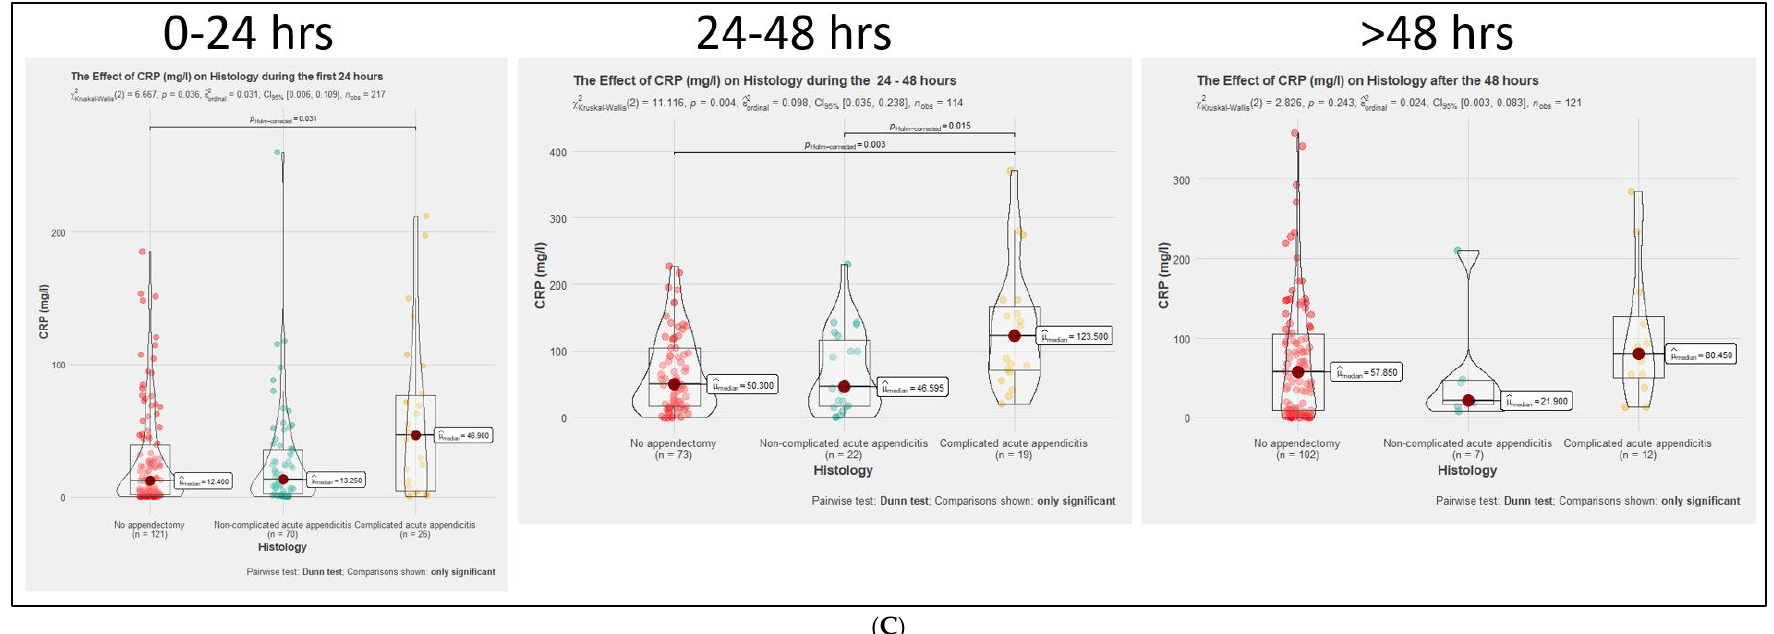
Figure 2. ( A ). No-AA—no acute appendicitis group, NAA—non-complicated acute appendicitis group, CAA—complicated acute appendicitis group, WBC—white blood cell, NEU—neutrophils. ( B ). No-AA—no acute appendicitis group, NAA—non-complicated acute appendicitis group, CAA—complicated acute appendicitis group, LYMP—lymphocytes, NEU/LYMP—neutrophil to lymphocyte ratio. ( C ). No-AA—no acute appendicitis group, NAA—non-complicated acute appendicitis group, CAA—complicated acute appendicitis group, CRP—C-reactive protein.